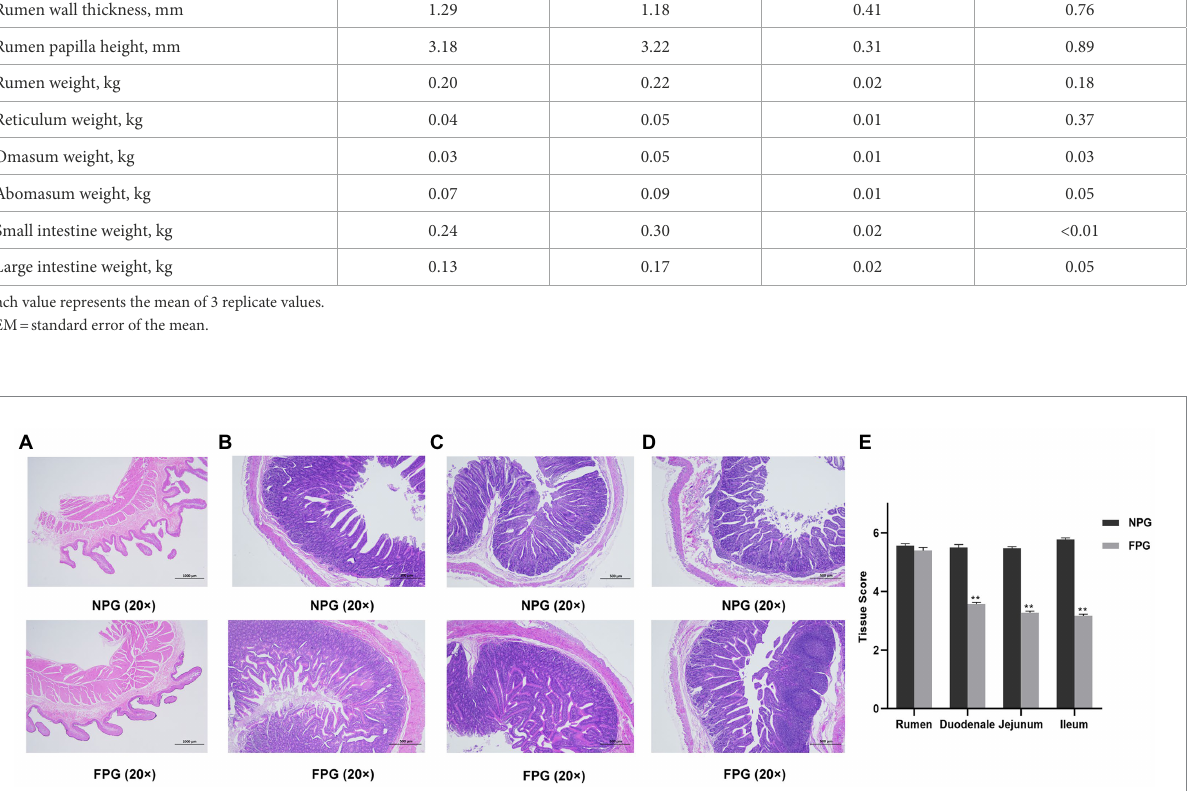
Performance indexes of gastrointestinal tract were shown in Table